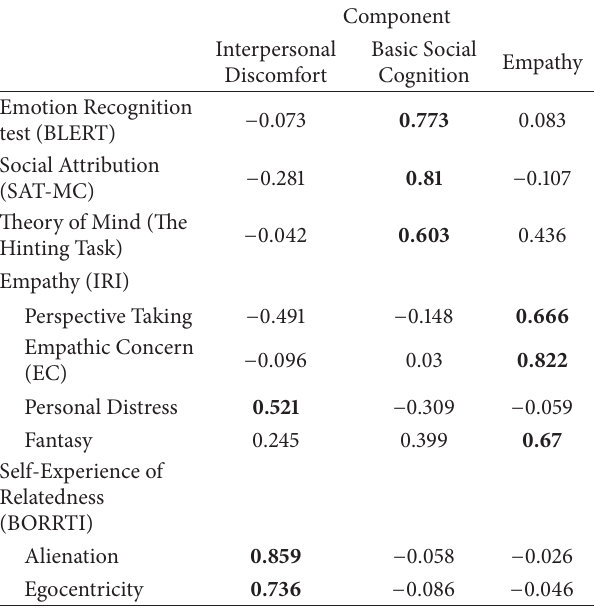
Table 5: Factor loadings of the social cognitive